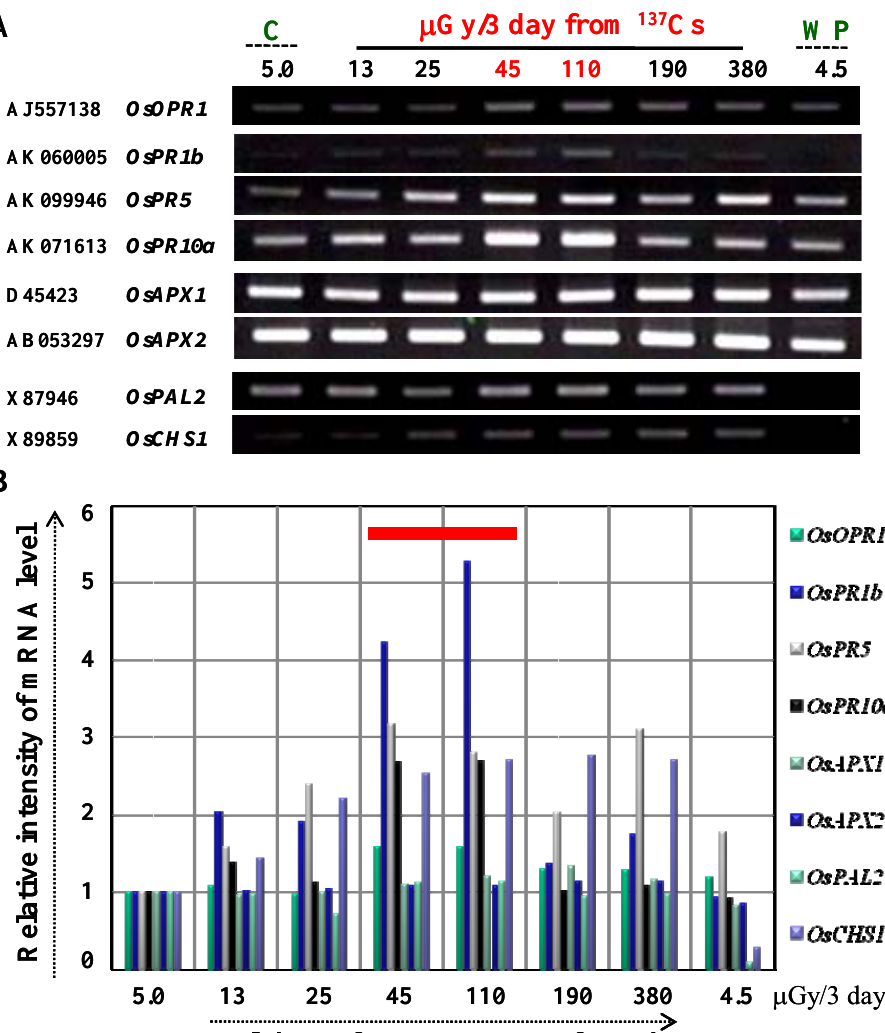
Figure 2. Effects of ultra low-dose  -radiation using in-house fabricated radiation source on mRNA expression level of marker genes in leaves of rice seedlings by RT-PCR.